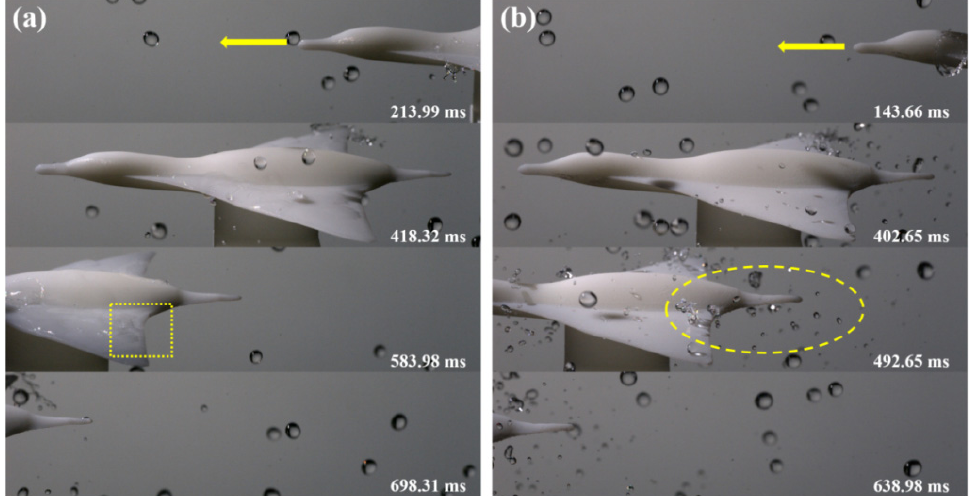
Figure 6. Comparison of antiwetting properties on the moving hydrophilic and superhydrophobic models. ( a ) Adhesion of water on moving hydrophilic surfaces. Moving reduces wetting of the surface compared with when the model is stationary; only the trailing edge of the wing is wetted (see the area selected in the yellow square). ( b ) Excellent antiwetting based on motion and superhydrophobic coupling. The movement of the surface and the superhydrophobicity together promote dynamic water repellency, with smaller-sized droplets occurring in the upstream direction (see elliptical area). No areas were wetted. (See details in “Supporting Movie S5” and “Supporting Movie S6” in the Supplementary Material.).